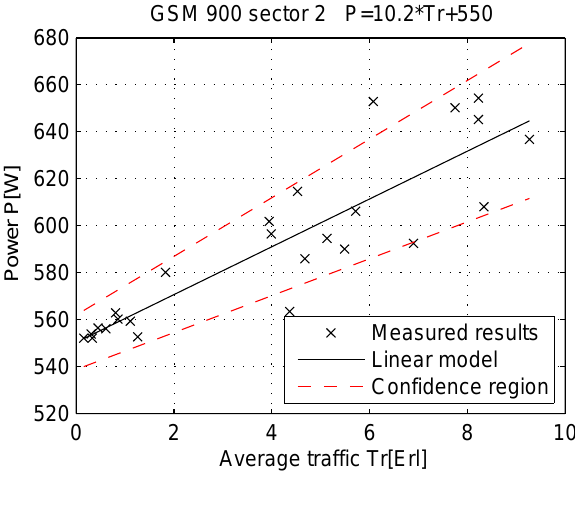
Figure 29. Power consumption model of GSM 900 sector 2 BS rack (Sunday,